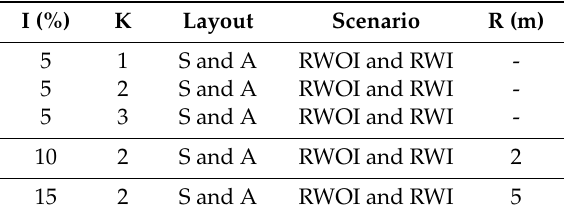
Table 3. The di ff erent numerical experiments performed in this